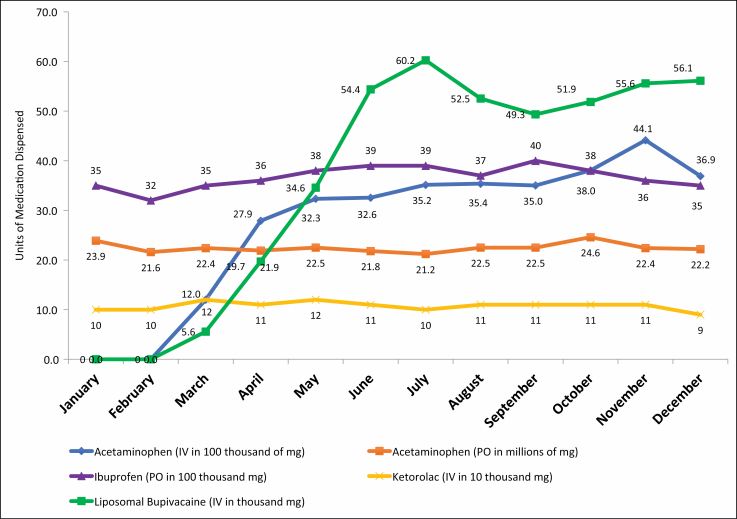
Adjunctive nonopioid medications dispensed to operating rooms and inpatients in 2018